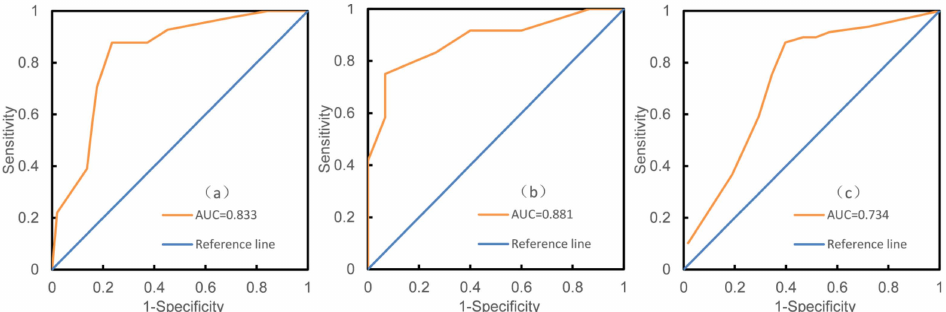
Figure 7. The ROC curves based on the validation dataset: ( a ) of the model for Beichuan County; ( b ) of the model for Yanzi River Basin; ( c ) of the unified model.